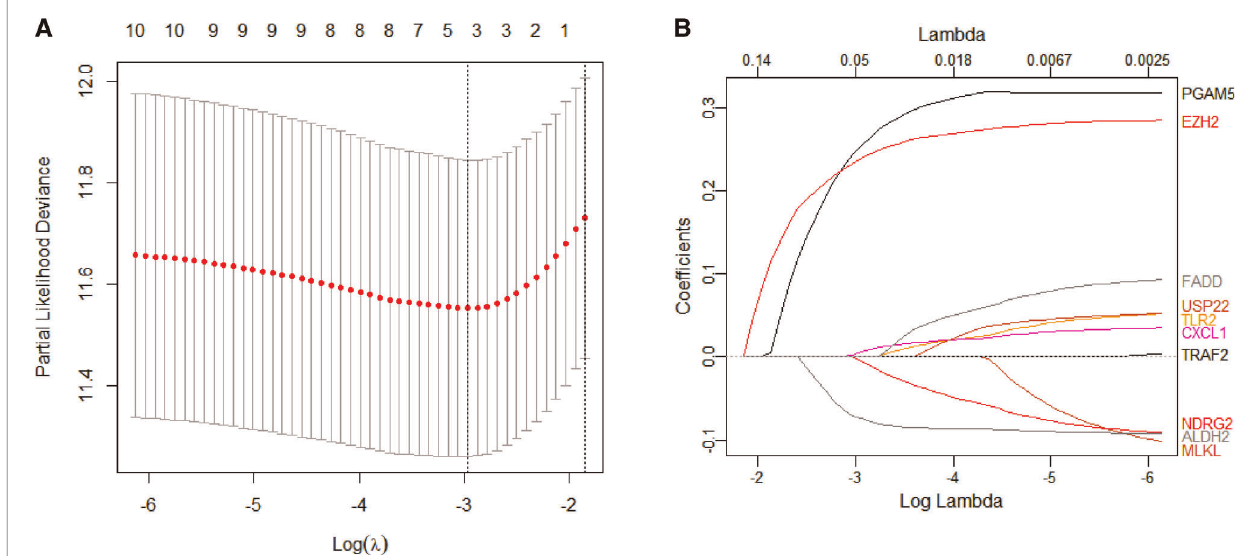
FIGURE 5 | ( A and B ) Coef fi cient and partial likelihood deviance of the Risk Score Signature.